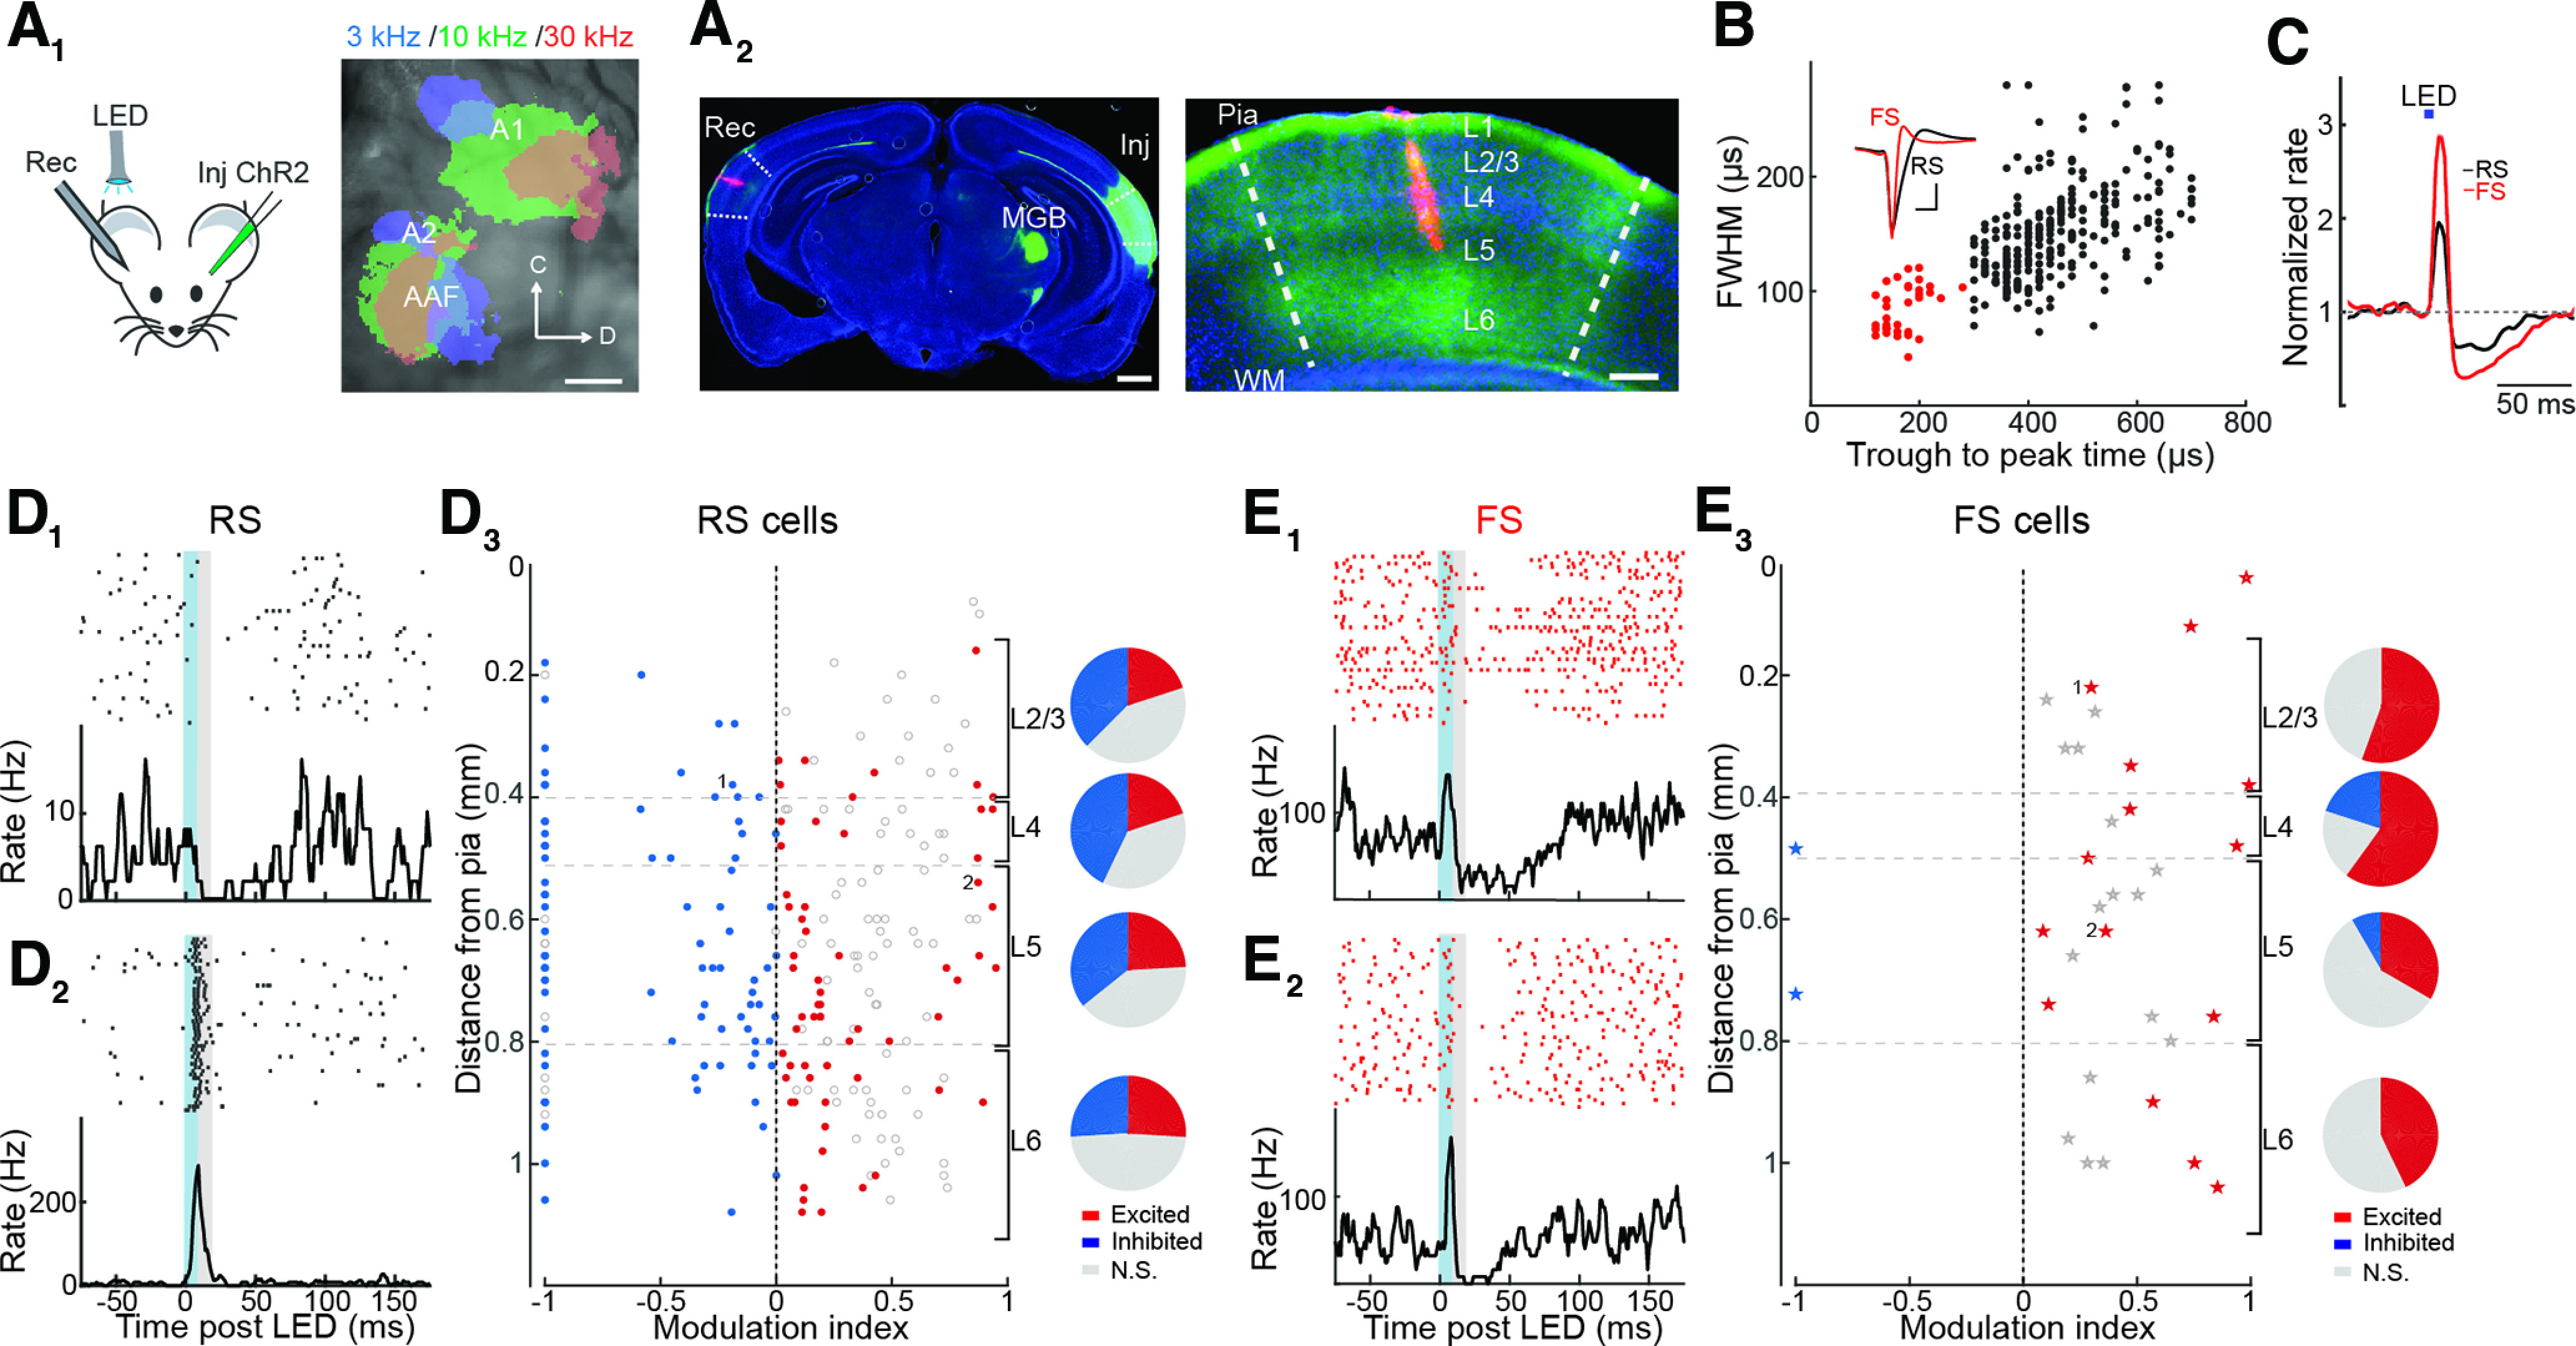
Optogenetic activation of cortical callosal inputs evokes excitation and inhibition in A1 of awake mice. A1, left, Experiment schematic, wild-type C57Bl6 mice. Right, Intrinsic imaging showing responses to 3-, 10-, and 30-kHz pure tones overlaid on an image of the vasculature. Areas indicated are A1, AAF, and A2. Scale bar = 500 μm. A2, left, Coronal section showing ChR2 expression (green) within A1 of the injected left hemisphere (Inj) and DiI-labeled recording electrode tract (red) in contralateral A1 (Rec). Dense ChR2 expression is also present in the MGB of the injected hemisphere. Scale bar = 1 mm. Right, Blow-up of recording site in the right hemisphere shows expression of ChR2-expressing fibers throughout all cortical layers. WM = white matter. Scale bar = 250 μm. Dashed lines show A1 border inferred from the same coronal planes according to Franklin and Paxinos (2008). B, FS (red) and RS (black) units are identified by plotting spike trough to peak time versus full width at half maximum (FWHM). Inset, Average waveforms of FS and RS units. Scale bar = 250 μs, 20 μV. C, Average normalized peristimulus time histogram (PSTH) of RS (black) and FS (red) units shows that brief LED illumination (bar) drives a transient increase followed by a decrease in firing rate. D, Activation of callosal inputs increases activity of some RS cells, but inhibition is more widespread. D1, Individual RS unit spike raster and PSTH showing that ChR2 activation of callosal fibers (blue shading) inhibits firing. Gray shading indicates measurement period used to calculate modulation index. D2, RS unit strongly activated by callosal input. D3, left, Modulation index of units significantly activated (red) or inhibited (blue) across all layers. Open circles indicate units without significant effect and points marked 1 and 2 represent units in D1, D2, respectively. Right, Pie charts indicate proportion of units excited (red), inhibited (blue), or not significantly modulated (gray) in each layer. E, Activation of callosal inputs activates FS cells across all layers. Two representative FS units are plotted in E1, E2. E3, Modulation index of FS units across all cell layers are illustrated as for RS cells in D3.